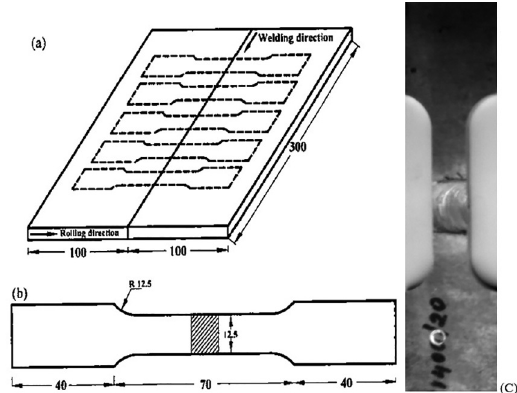
Figure 2: (a) Scheme of extraction 1 and (b) dimensions of tensile specimen (c) Sample specimen. base metal was present in TMAZ and appeared in dark gray. The Zinc particles shows huge granular and metallic shine in the advancing and retreating sides of the specimen (Figure 4.(a)&(c), 5.(a)&(c), 6.(a)&(c)). It is observed that the flow of interlayer from the retreating side never enters into advancing side. But material from the advancing zone is somehow displaced and that causes a heterogeneous zone and causes a flow variation in the in advancing and retreating sides. The same also evidenced in the microhardness